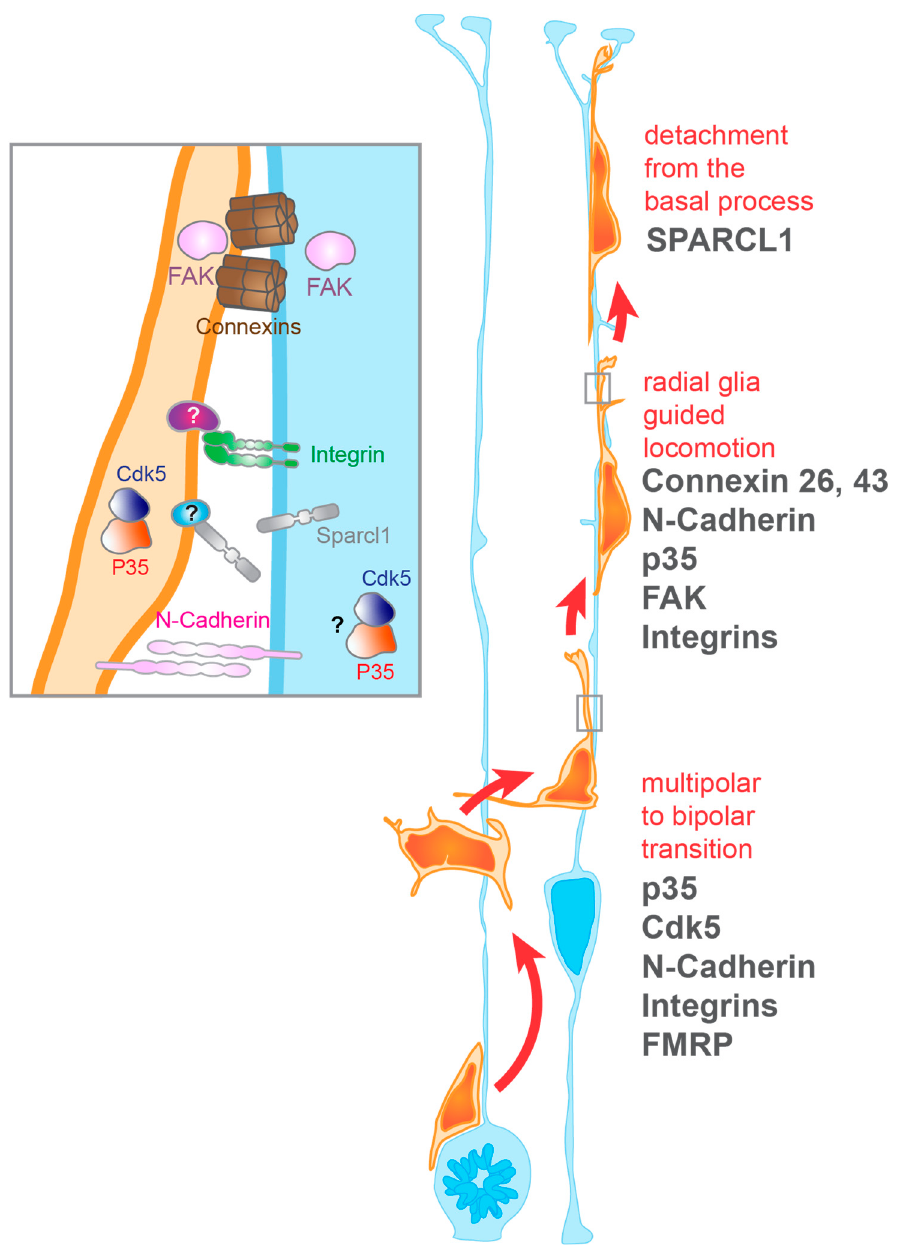
Figure 2. Mechanisms regulating radial glia-migrating neuron interactions involved in specific migratory stages. Inlay shows the cell surface interface between the radial glia process and the migrating neuron. Cell surface proteins and their regulation are critical to the proper guidance of the migrating neuron.